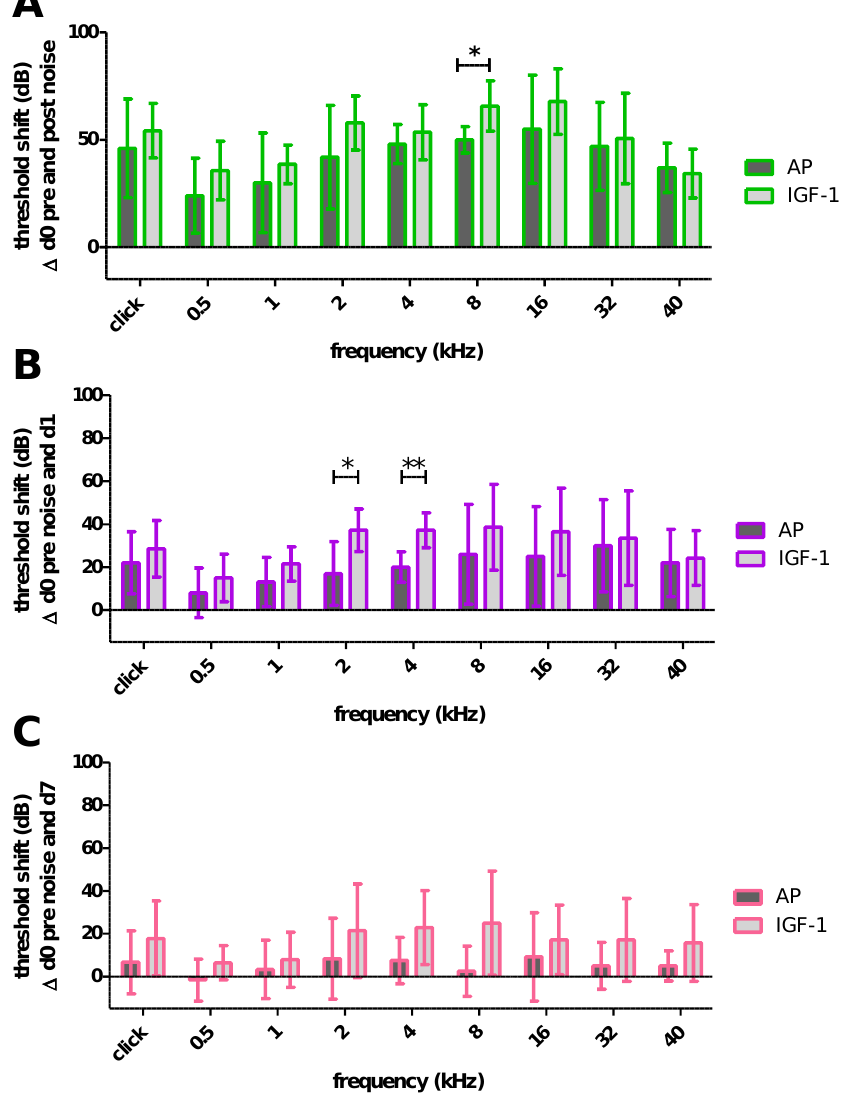
Figure 4. Mean and SD noise-induced threshold shifts of the implanted ears of both treatment groups at different time points. ( A ) 30 min after the noise exposure the IGF-1 group showed a significantly higher threshold shift at 8 kHz. ( B ) One day after the noise exposure there is a frequency specific recovery with significantly higher shifts at 2 and 4 kHz in the IGF-1 treated animals. ( C ) One week after the noise trauma the recovery proceeds and both groups do not show significant differences anymore. Only significant differences are illustrated in A, B and C; * p ≤ 0.05; ** p ≤ 0.01.